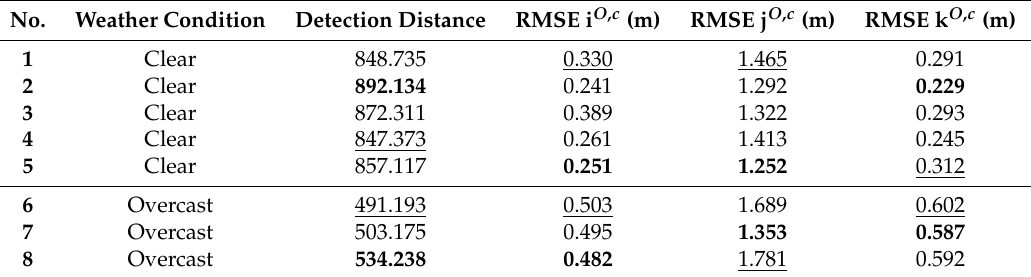
Table 4. Eight experiment results in different weather condition.